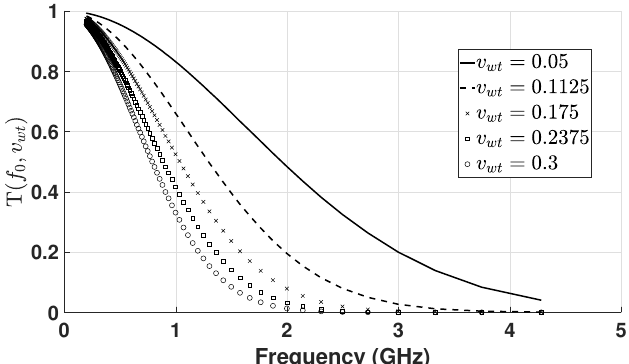
Figure 3. Transmittance as a function of frequency between 0.2–4.2 GHz with d = 0.4 m and v wt between 0.05 and